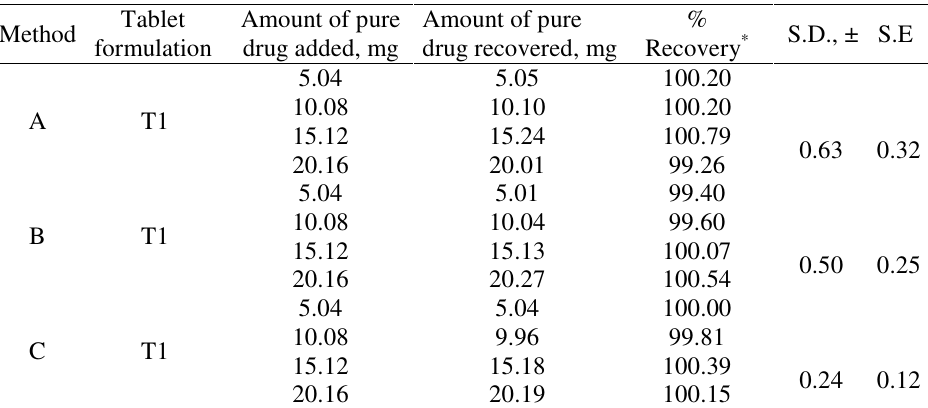
Table 3a. Recovery study data